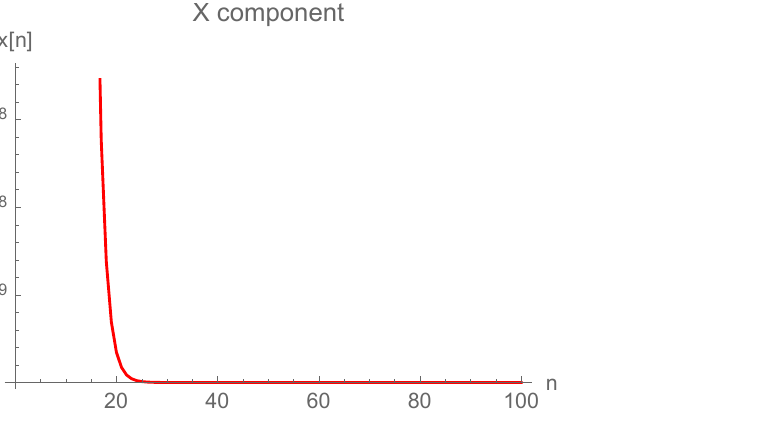
Figure 15. Graph of x n for α = 0.5, β = 1.7, γ = 1.6, δ = 0.3, ζ = 0.7, η = 1.6, µ = 2.7, ε = 0.6, υ = 0.8, ρ = 1.11, σ = 1.11, ω = 0.2. with initial conditions x 0 = 0.002, y 0 = 0.0084 and z 0 =